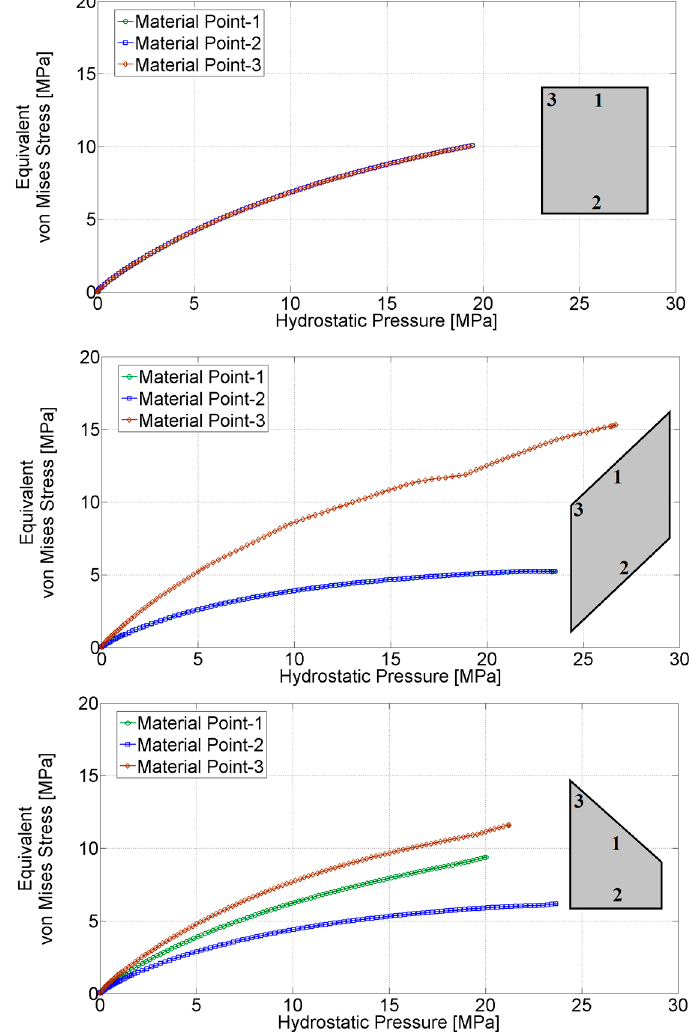
Figure 7. Stress path for selected material points.